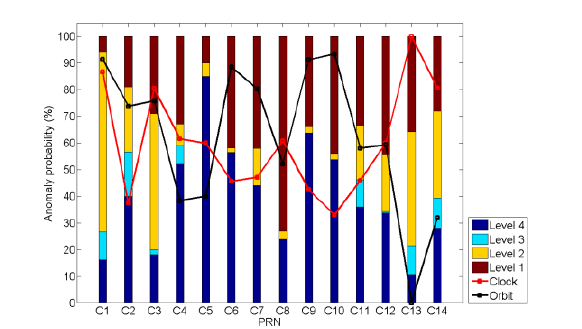
Figure 6 Anomaly probabilities in 4 different range levels and probabilities of clock and orbit